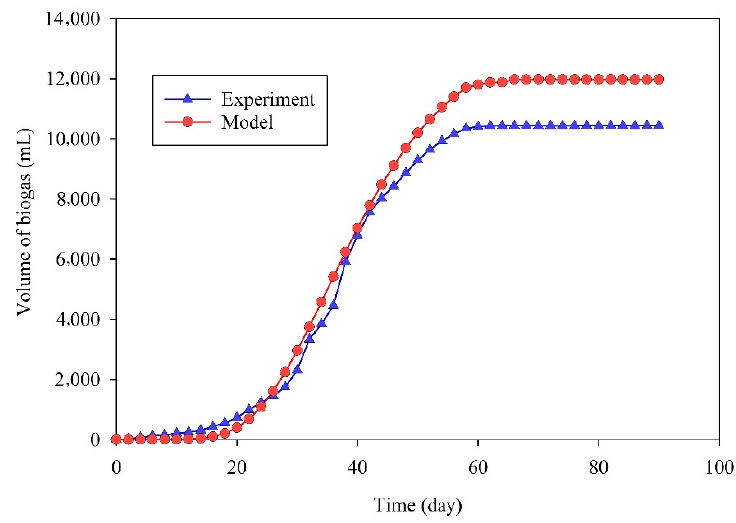
Figure 13. Comparison of actual vs. estimated volume with a content of 25% total solids (TS), 25 (g/g) C/N ratio, and delignification.